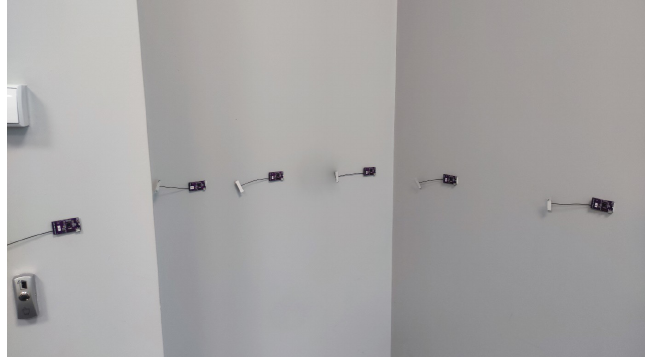
Figure 9. View of the wall of the test room subjected to the RTI system built with 32 probes—without a power supply.